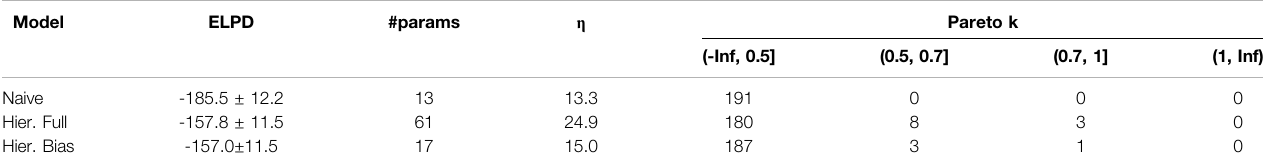
TABLE2| ComparisonofthethreemodelsusingPSIS-LOO-CV.TheELPD ± onestandarddeviationarelistedforeachmodel.#paramsdenotesthenumberofparameters, η denotes the effective number of parameters. For each model, we show the number of data-points for which the Pareto shape parameter k falls into either of four different